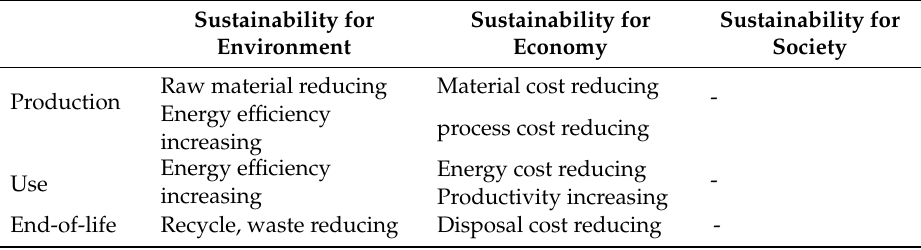
Table 3. Benefits of light weight for sustainability of machine tools in each life cycle phase. Sustainability